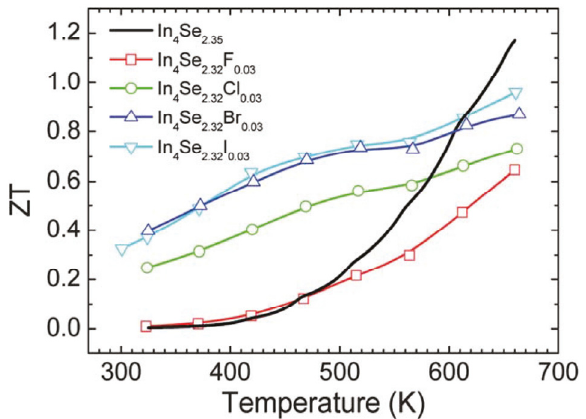
Figure 18. Temperature dependence of the thermoelectric figure of merit of the crystals of In 4 Se 3 − x H 0.03 ( x = 0.68; H = F, Cl, Br, I) and In 4 Se 2.35 [32]. 2.3.3. Multiple Elements Doping and Selenium Deficiency in Polycrystalline In 4 Pb 0.01 Sn 0.03 Se 3 − x